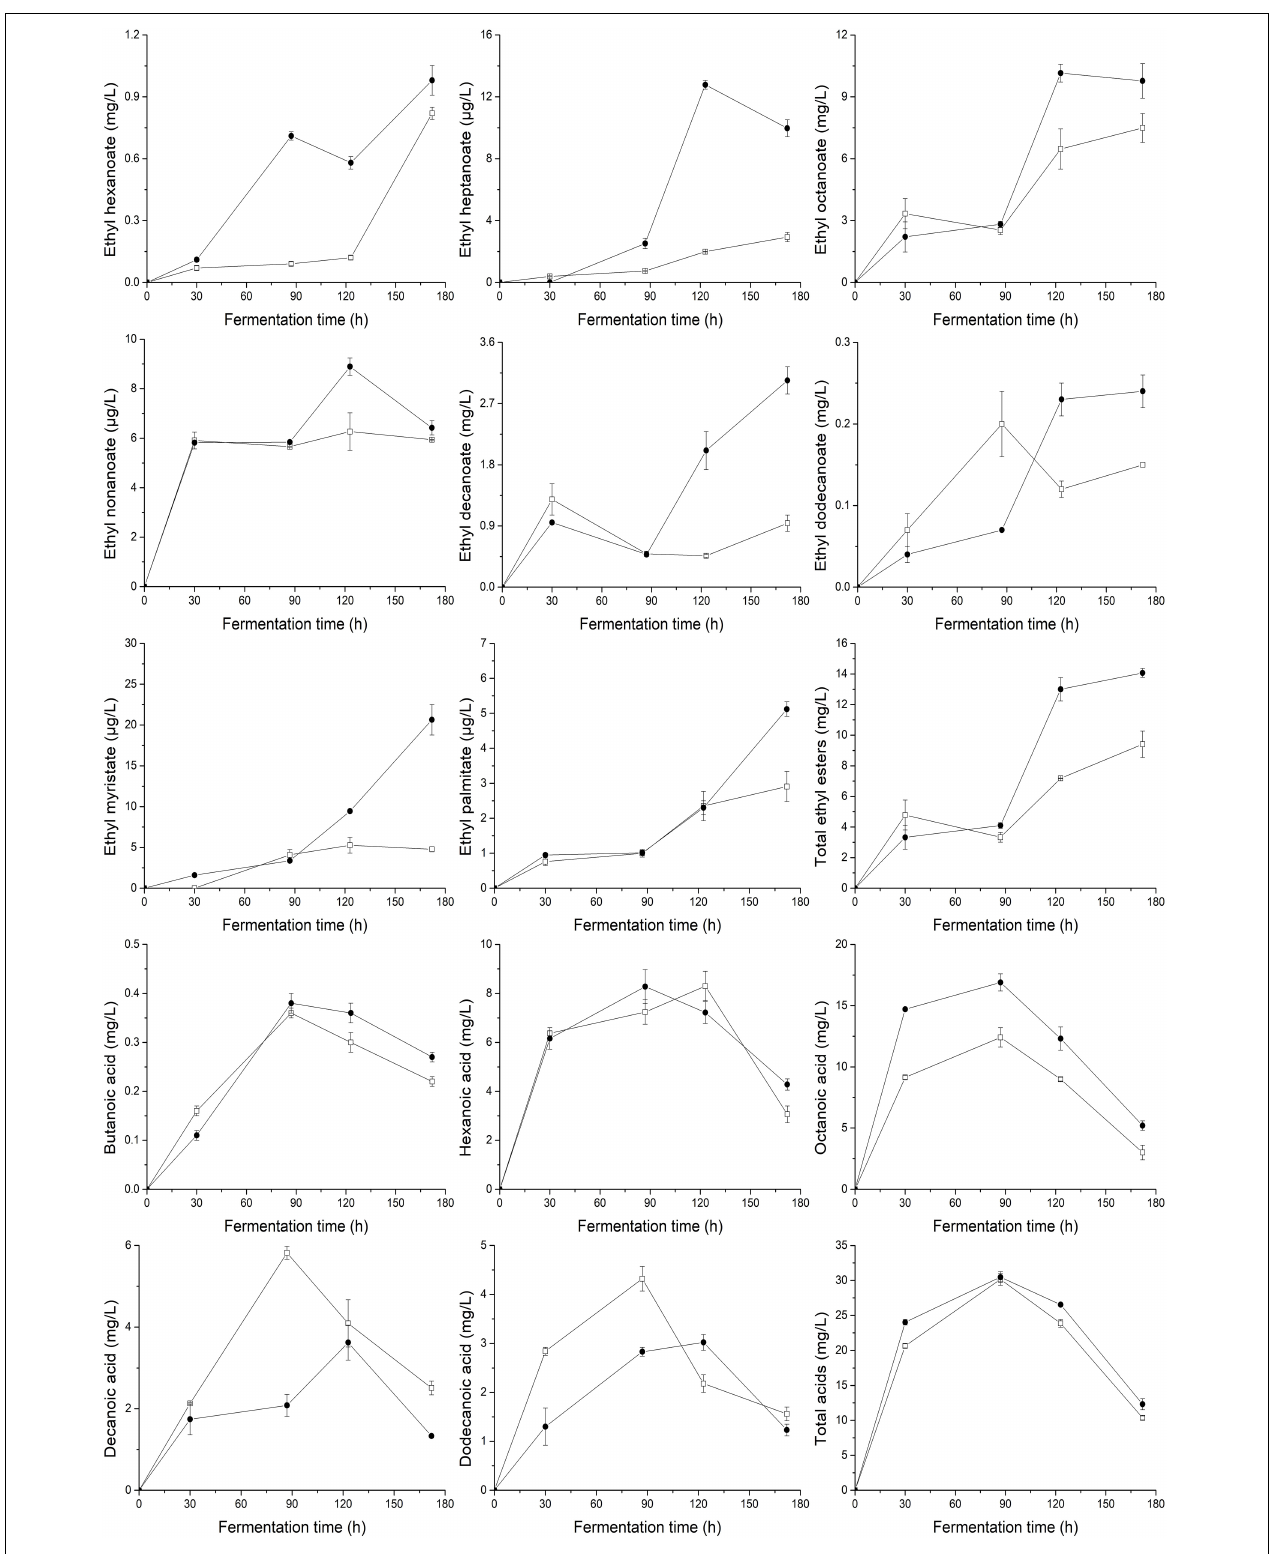
FIGURE 4 | Profiles of major ethyl esters and the total content of ethyl esters, fatty acids and the total content of fatty acids during the fermentation of MS300 media with high ( ) and low ( ) UFA concentrations. Data points represent the mean value from triplicate fermentations, and the vertical bars show ± SD. (cid:32) (cid:50)